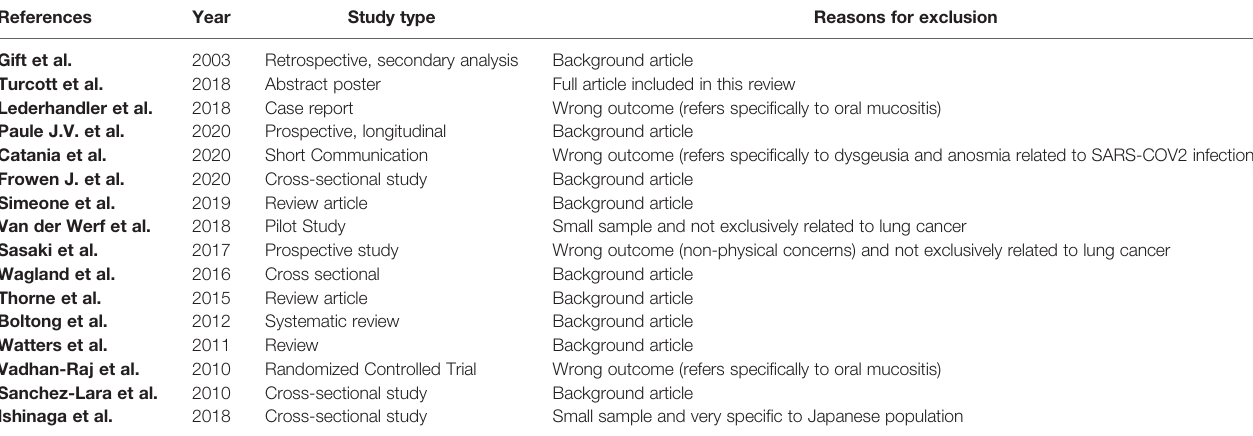
TABLE 5 | Summary of the excluded articles with